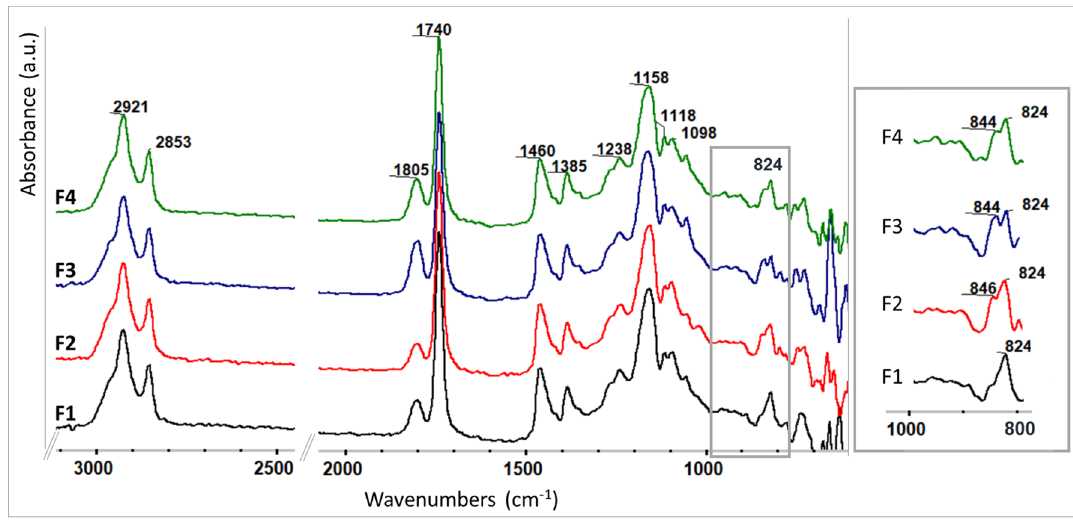
Figure 4. FTIR spectra of the initial (unpolymerized) ELALO and ELALO-SDA systems. Detail— cropped and zoomed spectral region from 1000–800 cm − 1.